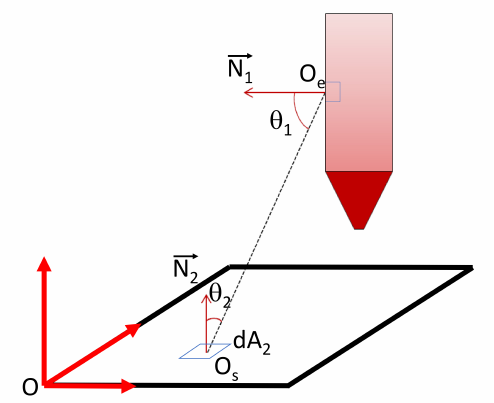
Figure 4. Geometrical configuration for the View factor